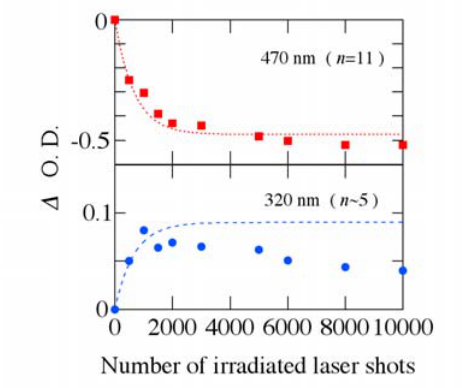
Figure 8. Absorbance changes due to the photodegradation of β -carotene in PMMA films as a function of number of the irradiated excitation laser